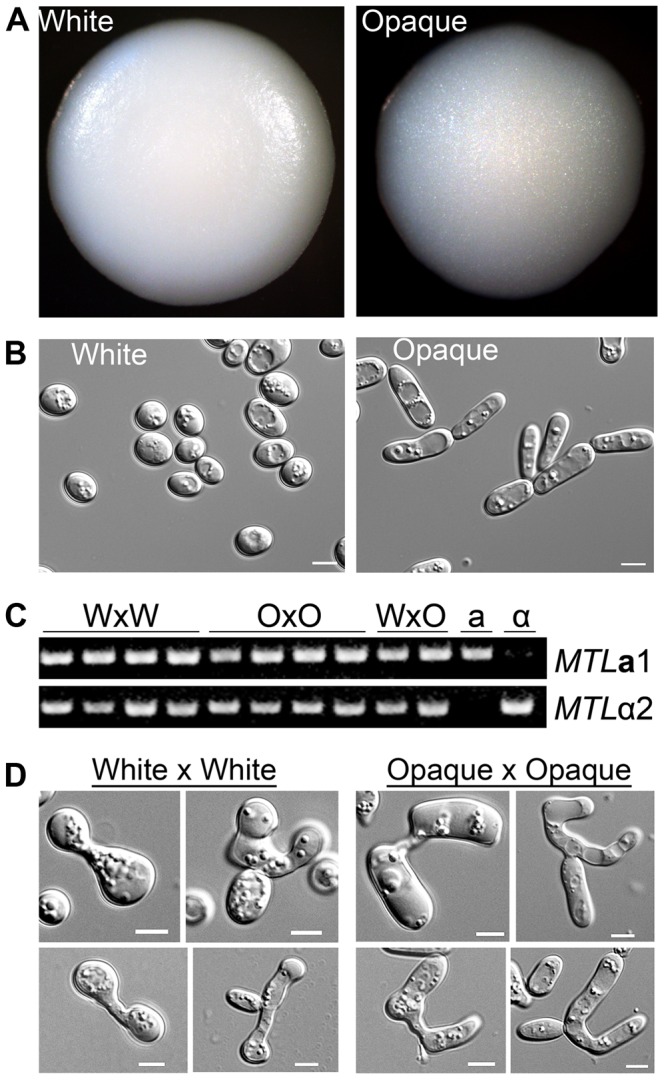
Products of C. tropicalis white×white and opaque×opaque mating maintain parental phenotypes.(A) Colony morphology of mating products. Left, product of mating C. tropicalis white a (CAY3376) with white α (CAY3391) cells. Right, product of mating opaque a (CAY3378) with opaque α (CAY3392) cells. Colonies were grown on SCD medium lacking histidine and arginine for 3 days at room temperature to select for mating products. (B) Cell morphology of cells taken from the corresponding colonies. Scale bars = 5 µm. (C) PCR to verify the presence of MTL
a1 and MTLα2 genes in white×white (WxW) mating products, opaque×opaque (OxO) mating products, white×opaque (WxO) mating products, and in the parental a and α strains. (D) Left, pictures of zygotes analyzed from white×white mating experiments and, right, pictures of zygotes analyzed from opaque×opaque mating experiments. Scale bars = 5 µm.